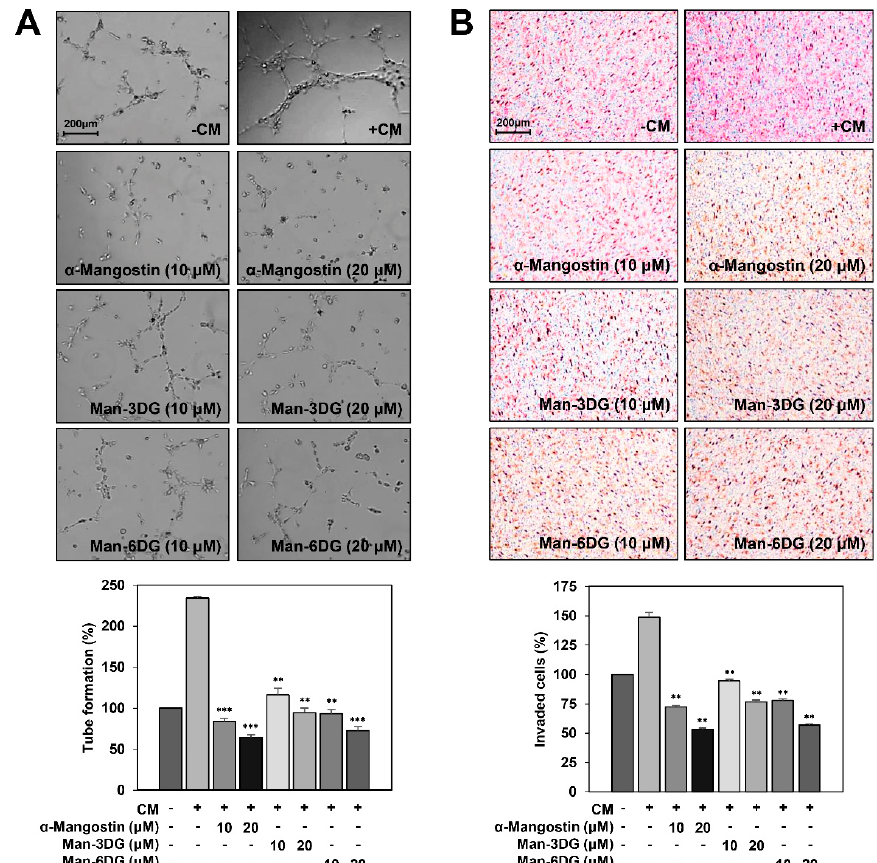
Figure 8. The effects of α -mangostin glycosides on the Hep3B cell-induced angiogenesis. The tumor cell-induced angiogenesis was assessed using ( A ) a conditioned medium from tumor cells for in vitro tube formation assay, and ( B ) an in vitro co-culture system based on the chemoinvasion assay. Hep3B cells were treated with 10 and 20 μ M of α -mangostin, Man-3DG, and Man-6DG for 24 h. ( A ) The basal level of the tube formation of human umbilical vein endothelial cells (HUVECs) that were treated with non-conditioned medium without Hep3B cells was normalized to 100%. Each value represents the mean ± SD from three independent experiments. ** p < 0.01 and *** p < 0.001 versus the conditioned medium from untreated Hep3B cells. ( B ) The basal level of the invasiveness of HUVECs that were incubated in a serum-free medium without Hep3B cells was normalized to 100%. Each value represents the mean ± SD from three independent experiments. ** p < 0.01 versus the control with untreated Hep3B cells.